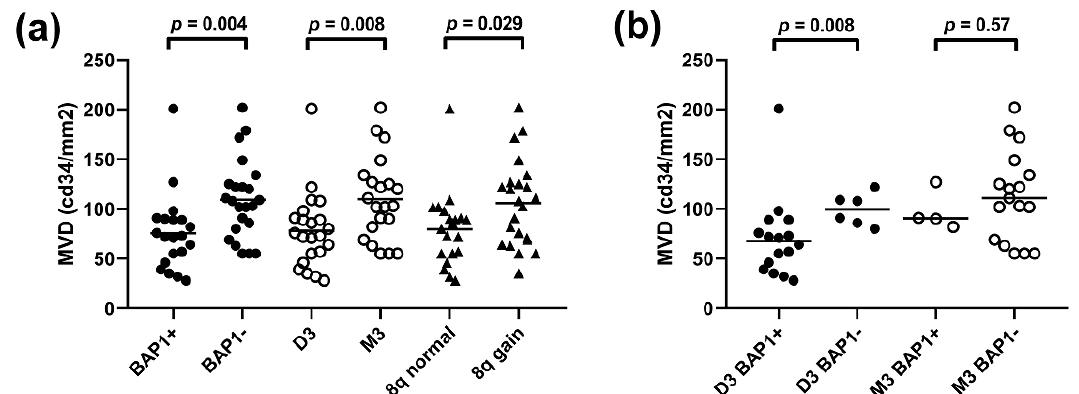
Figure 3. Tumour genetics in relation to MVD. ( a ) Within all 43 patients, patients were compared based on status of BAP1, chromosome 3 or chromosome 8q. ( b ) Within either disomy 3 ( n = 22) or monosomy 3 ( n = 21) patients, patients were compared based on status of BAP1. ( p -values were obtained using Mann–Whitney U tests. Abbreviations: BAP1+, BAP1-positive; BAP1 − , BAP1- negative; D3, Disomy 3; M3, Monosomy 3; 8q normal, normal chromosome 8q; 8q gain, gain of chromosome 8q).